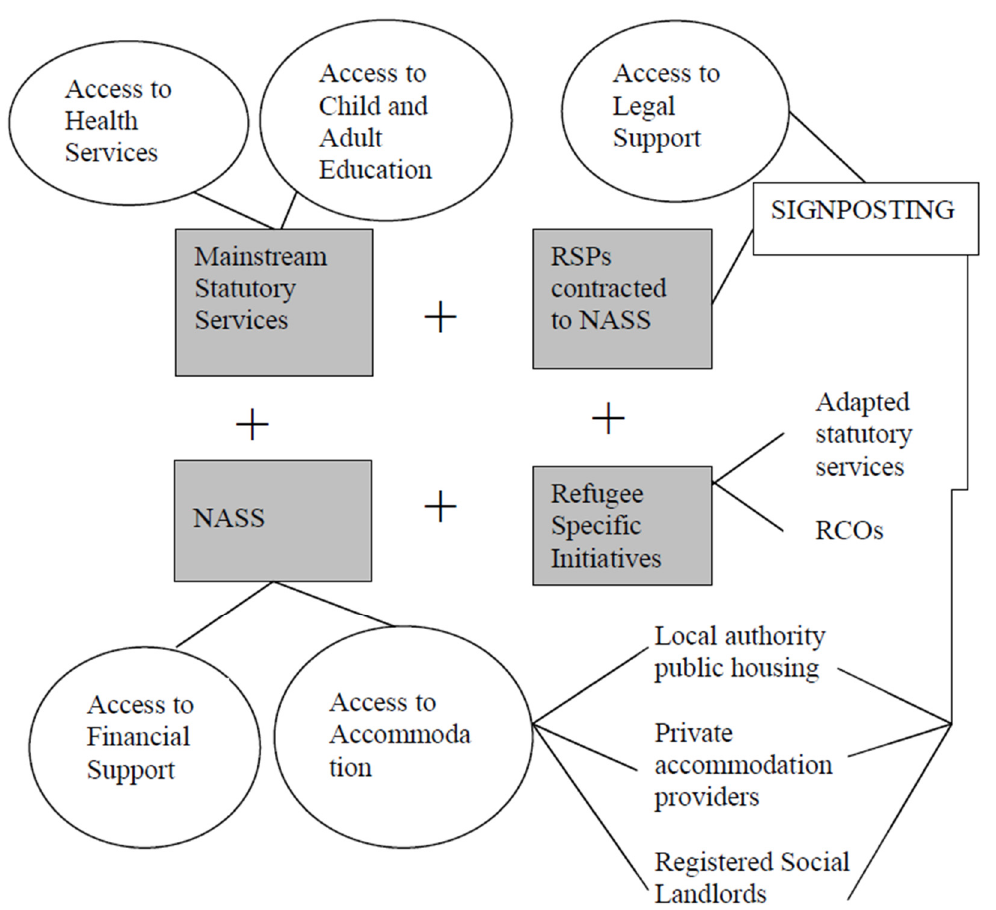
Figure 2. Structure of provision for asylum seekers upon introduction of compulsory dispersal.